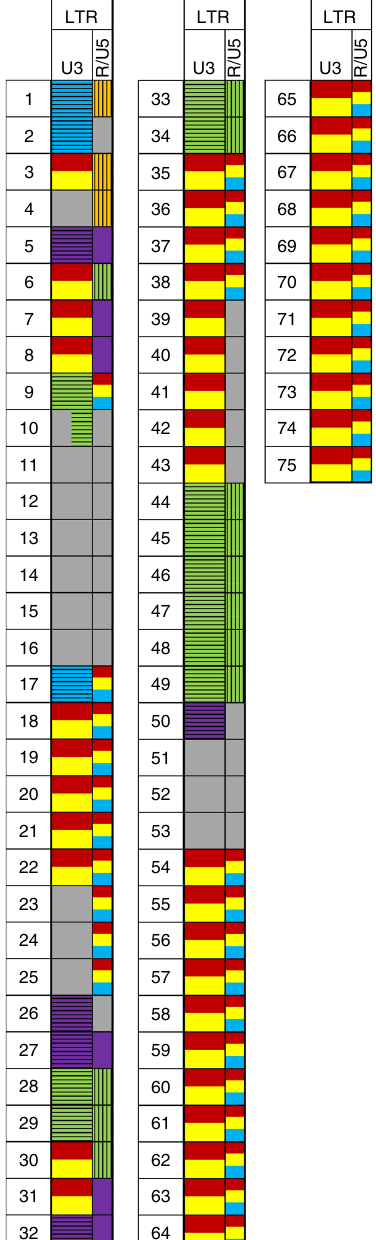
Fig. 3 Thirty-two cloned and Sanger-sequenced new chromosomal Onsen Onsen insertions found in progeny of a heat-stressed nrpd1-3 mutant plant 8 . Fig. 2 Origin of reconstructed LTRs of 75 new chromosomal